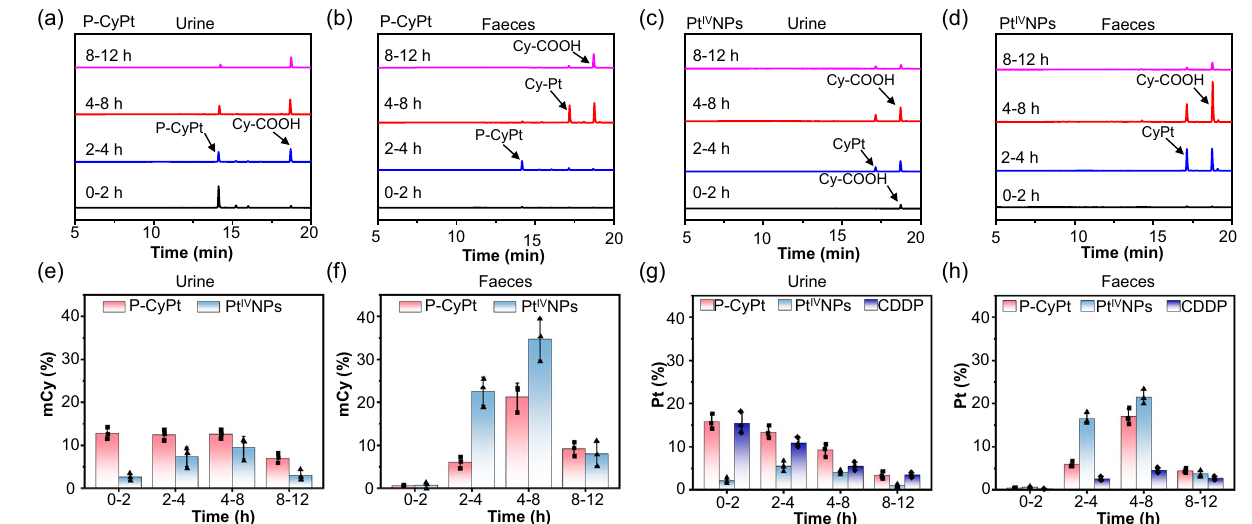
Fig.6|Evaluationofthemetabolism,clearance,andbiosafetyofP-CyPtinvivo. a – d HPLCtraces(660nmdetection)ofurine( a , c )andfaeces( b , d